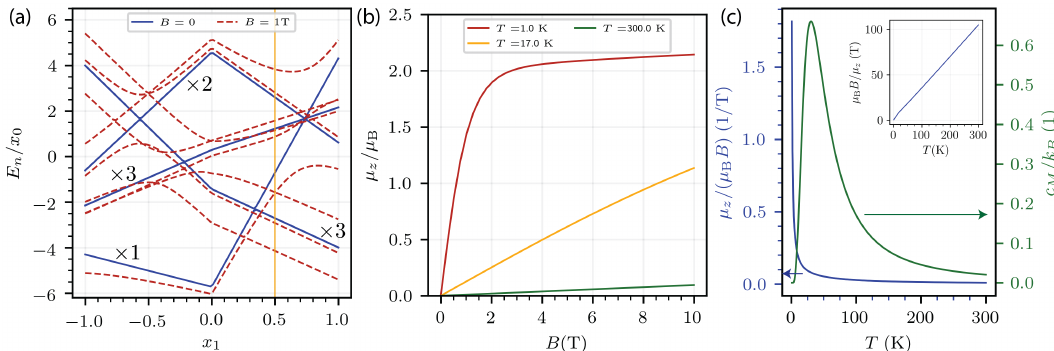
/ x Figure 1: (a) Energy levels E of a J = 4 rare-earth ion (Pr 3 + ) in cubic CF with n 0 point symmetry G = m¯3m as a function of Stevens parameter x . The degeneracy 1 of the levels in the absence of a magnetic field is indicated in the figure, and splits = 4 / 5. The in applied magnetic field B along the z axis. The g -factor is set to g JLS = 0.5, for panels ( b , c ) , where vertical yellow line indicates the parameter choice, x 1 = 20 K as absolute energy scale. (b) Magnetization per rare-earth we further set x 0 /µ ion µ as a function of applied magnetic field B along the z -axis for different tem- z B = 20 K and x = 0.5. The fully saturated peratures. The Stevens parameters are x 0 1 = 0.5 is µ /µ = 5 / 2 moment is reduced from the value in the ground multiplet at x z B 1 due to field-induced mixing into other states. (c) Magnetic susceptibility along z -axis /µ = µ / ( µ / k B ) (blue, left y -axis) and specific heat c (per rare-earth ion) χ z B z B M B (green, right y -axis) as a function of temperature T . The magnetic field is fixed to B = 10 − 4 T when computing χ . The Stevens parameters are identical to panel (b). z = µ B /µ The inset shows the inverse susceptibility χ − 1 , highlighting the Curie-like B z z behavior that occurs over the full temperature range due to the triplet ground state. / k The specific heat c shows a Schottky-like peak at a position proportional to the M B level splitting between the ground multiplet and the excited states ∆ = 40 K.